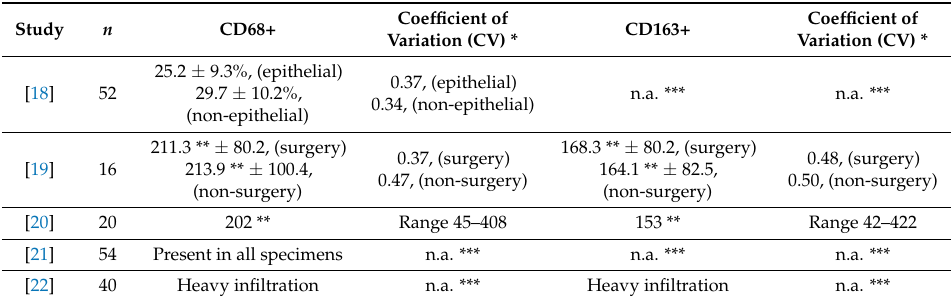
Table 2. Infiltration of TAMs and M2 macrophages in